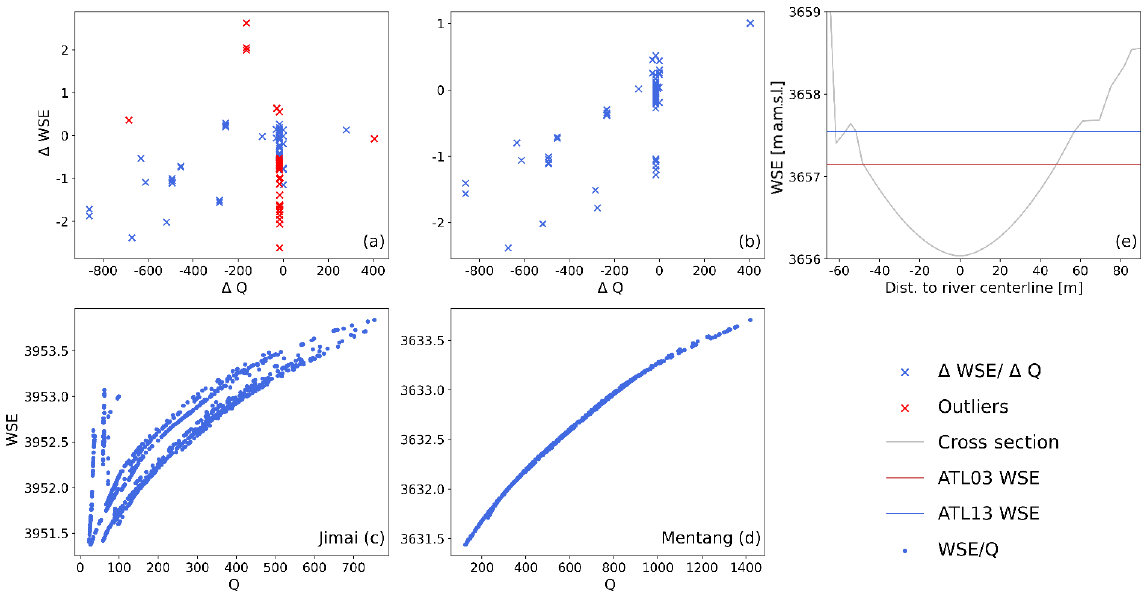
Figure 4. Variation in discharge against WSE from ATL03 and ATL13 (a) . Variation in discharge against the variation in WSE from ATL03 and ATL13 after correction (b) . Rating curve (discharge against WSE) for the Jimai gauging station (c) . Rating curve for the Mentang gauging station (d) . Example of mismatch between ATL13 and ATL03 WSE (e)